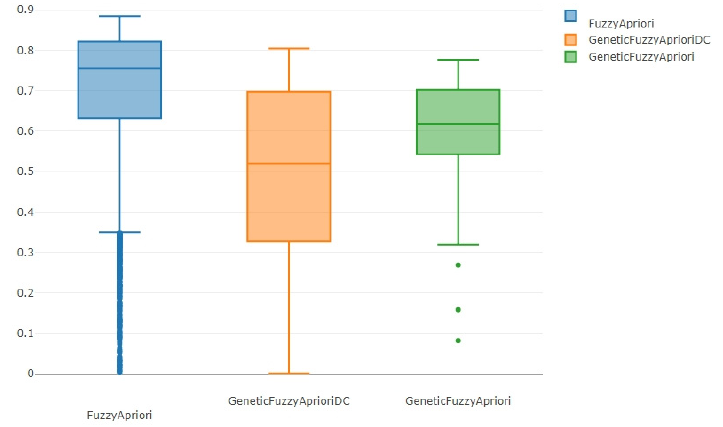
Figure 3. Boxplot of imbalance measure.